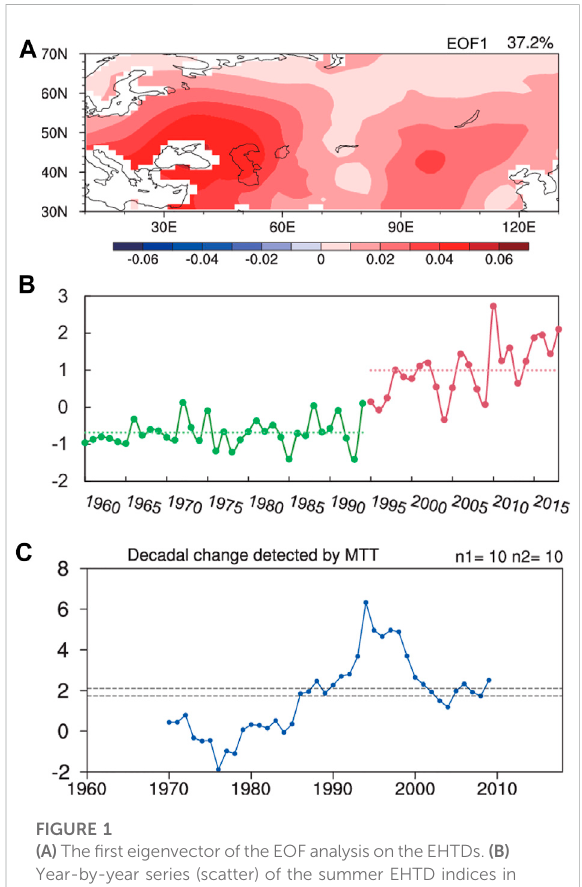
FIGURE 1 (A) The fi rsteigenvector oftheEOFanalysisontheEHTDs. (B) Year-by-year series (scatter) of the summer EHTD indices in northern Eurasia (10 ° – 130 ° E, 30 ° – 70 ° N) from 1960 to 2018, and the averaged values (dashed lines) of the index on time for 1960 – 1994 (P1) and 1995 – 2018 (P2), respectively. (C) Decadal changeofEHTDsinnorthernEurasiaaccordingtothesliding t -test (blue: sliding t -test statistic, two dotted lines for low and high indicate signi fi cance at 90% and 95% con fi dence levels,